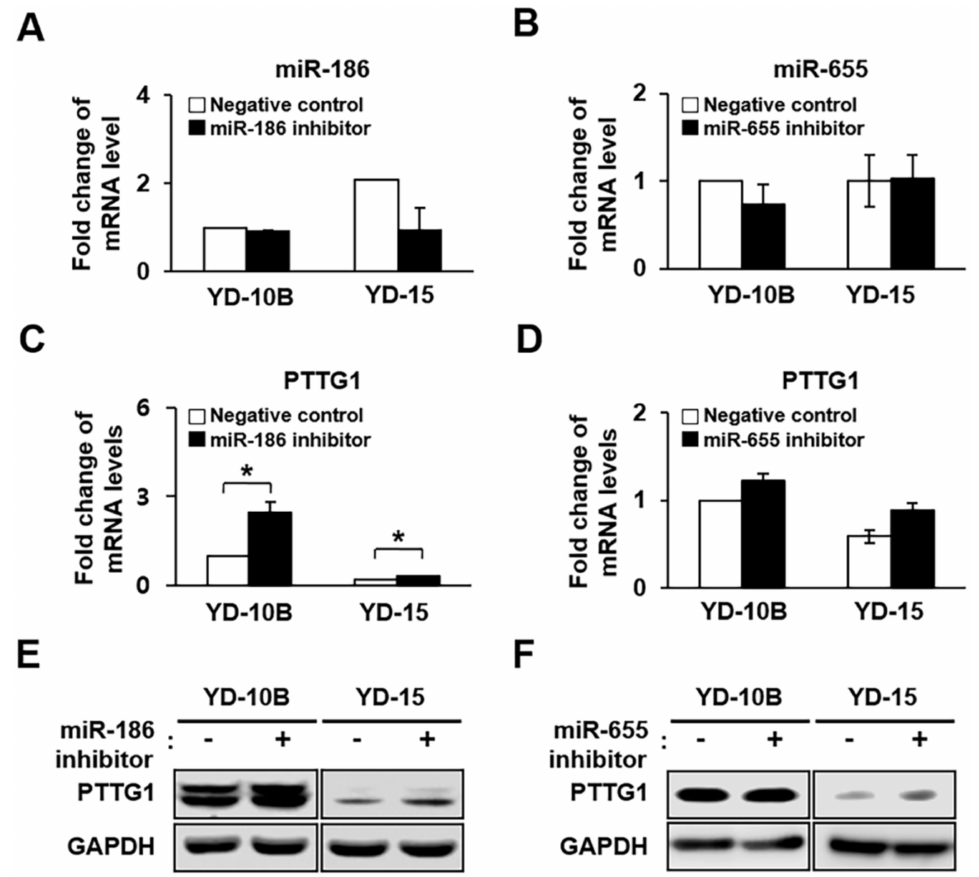
Figure 5. Effect of downregulation of miR-186 and -655 on PTTG1 expression in oral SCC cell lines. Expression of ( A ) miR-186 and ( B ) miR-655 determined by qRT-PCR in YD-10B and YD-15 cells treated with inhibitory sequences. mRNA expression of PTTG1 determined by qRT-PCR in YD-10B and YD-15 cells treated with ( C ) miR-186 and ( D ) miR-655 inhibitory sequences. * indicates significant differences between Negative control and inhibitor treatment ( p < 0.05). All experiments were performed in triplicate. Protein expression of PTTG1 determined by Western blots in YD-10B and YD-15 cells treated with ( E ) miR-186 and ( F ) miR-655 inhibitory sequence. GAPDH was used as an internal